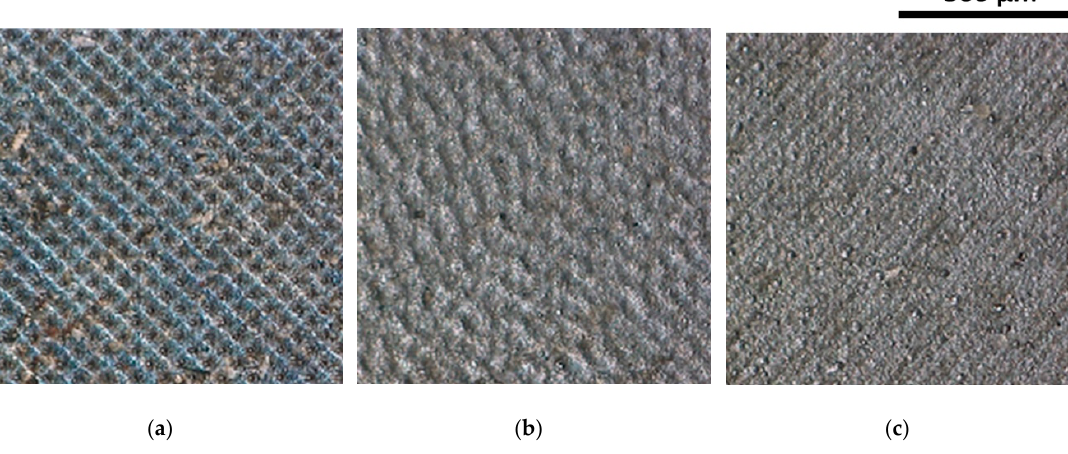
Figure 3. Scanning electron microscopy (SEM) images of surfaces morphology of laser-processed samples with a pulse frequency of 30 kHz and 20 repetitions. ( a ) 2000 mm/s, LINE strategy; ( b ) 1000 mm/s, NET strategy; ( c ) 1000 mm/s, CROSS strategy. Table 3. Laser operational process parameters for membranes